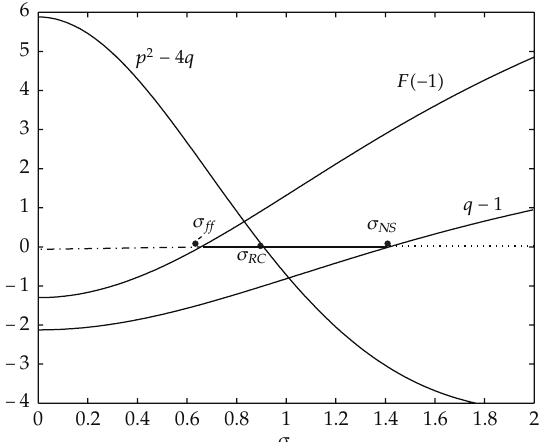
Figure 1: The parameter values are α (cid:7) 0 . 12, β (cid:7) 0, γ (cid:7) 0 . 375, ρ (cid:7) 0, and r (cid:7) 2 . 8.